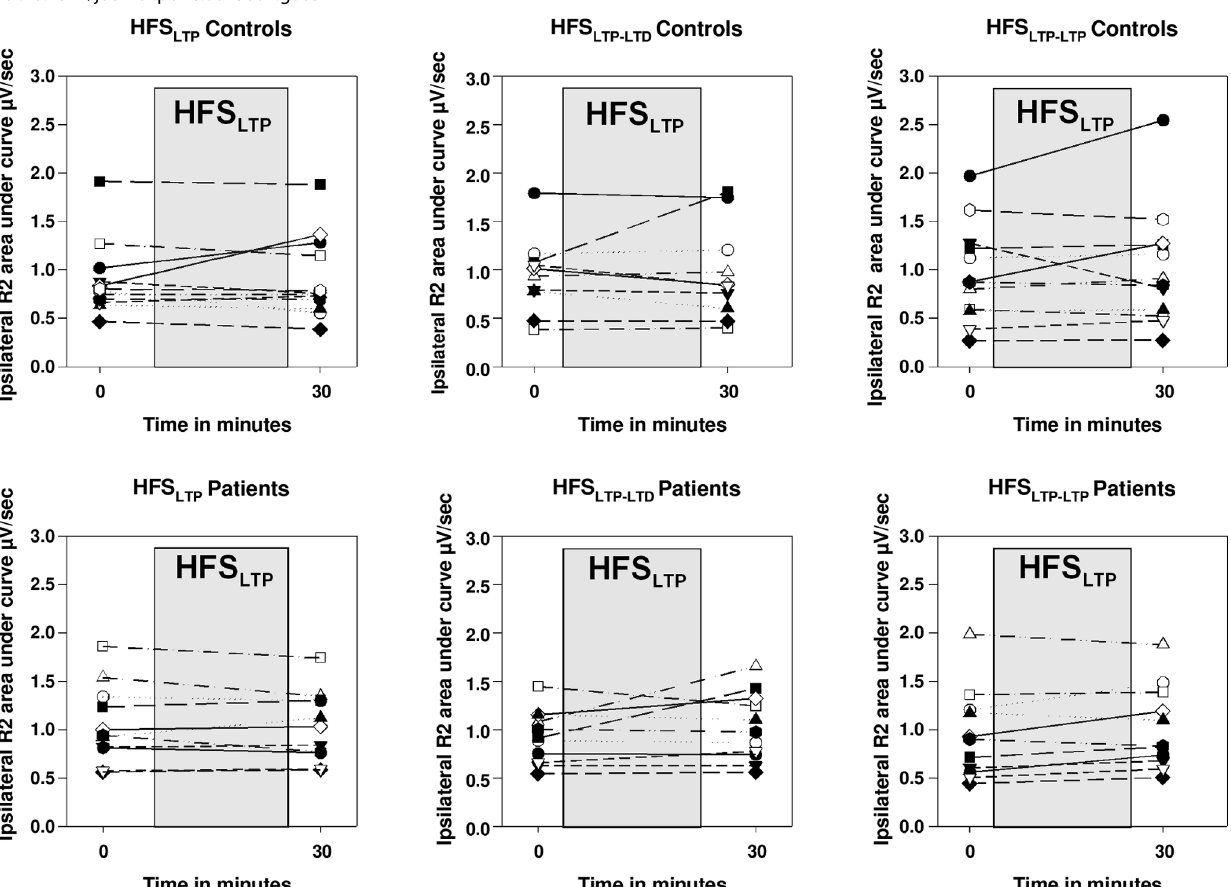
Figure 6. R2 response of each individual subject at baseline and after HFS LTP . Individual results of each subject before and immediately after HFS LTP for each protocol starting with HFS LTP (i.e. HFS LTP , HFS LTP-LTD , HFS LTP-LTP ) are presented.